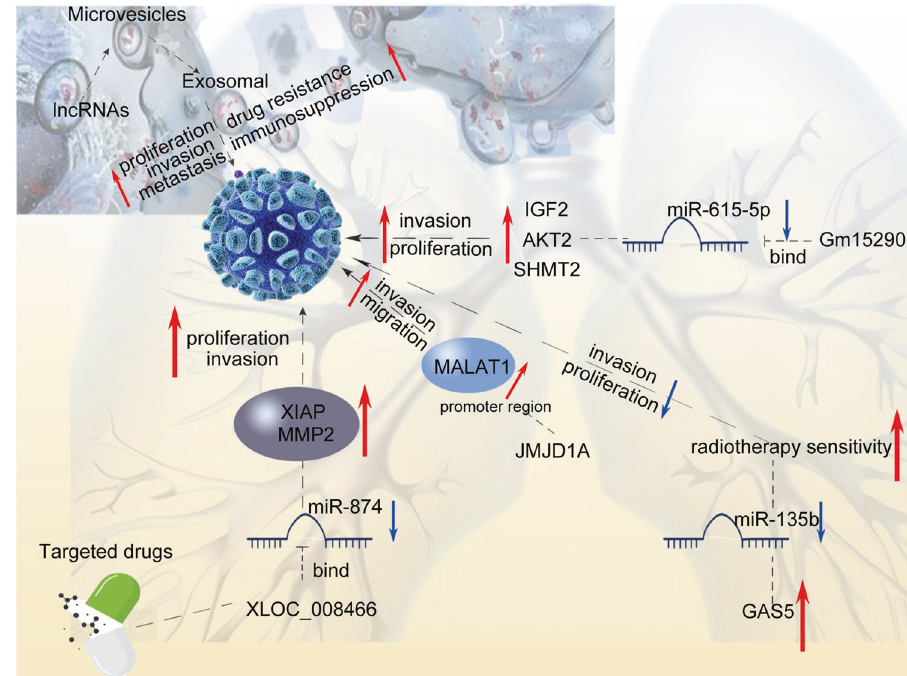
Fig. 2 Schematic of LncRNAs interact with microRNAs regimen in